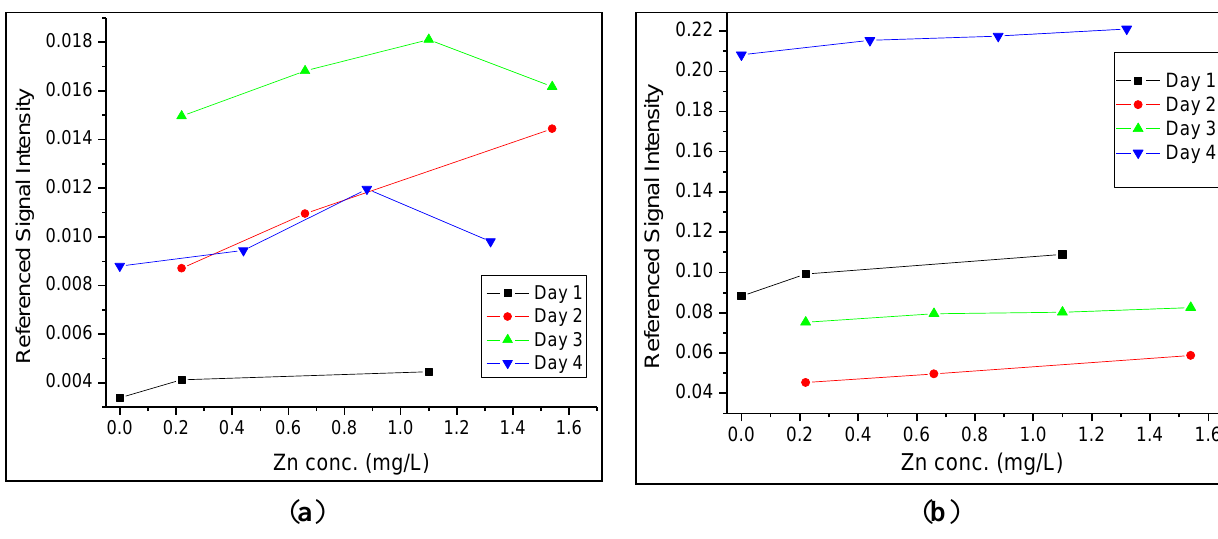
Figure 4. Calibration curves collected over multiple days ( a ) utilizing a fast photodiode as the excitation intensity reference, ( b ) utilizing a second cross-fiber sensor as the excitation intensity reference.